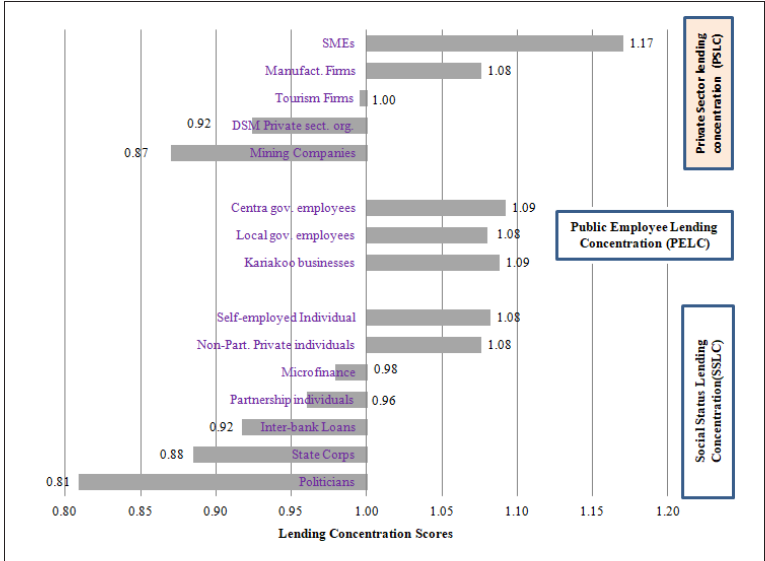
Perceived Customer Lending Concentration Across